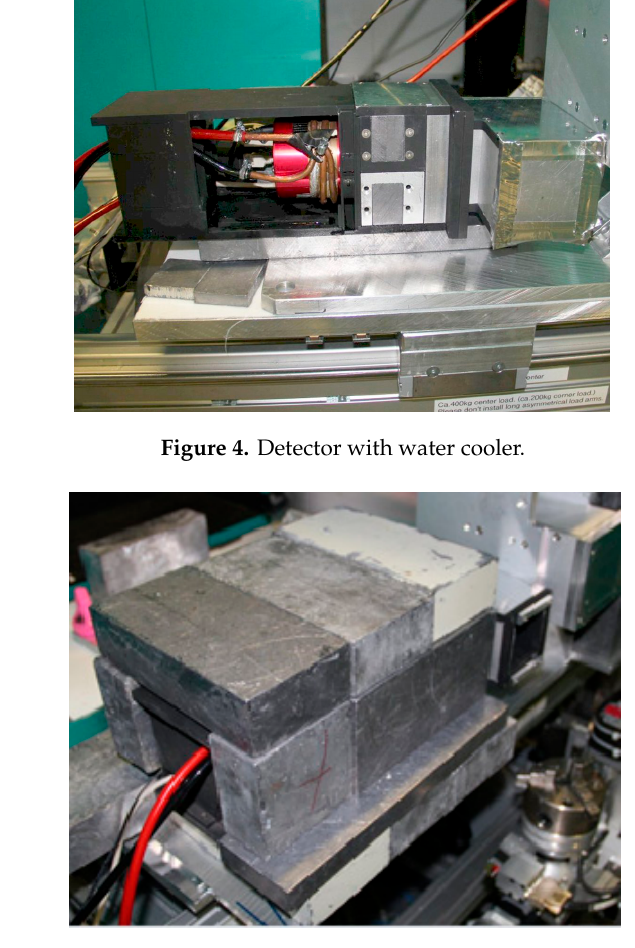
Figure 5. External shielding stacked.